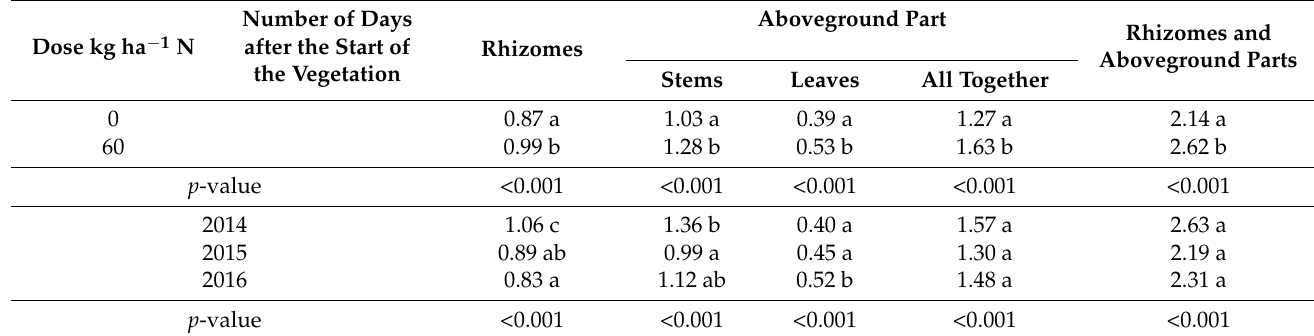
Table 8. Sulphur uptake by the giant miscanthus in g · m − 2 (average for the years 2014–2016). Dose kg ha − 1 N